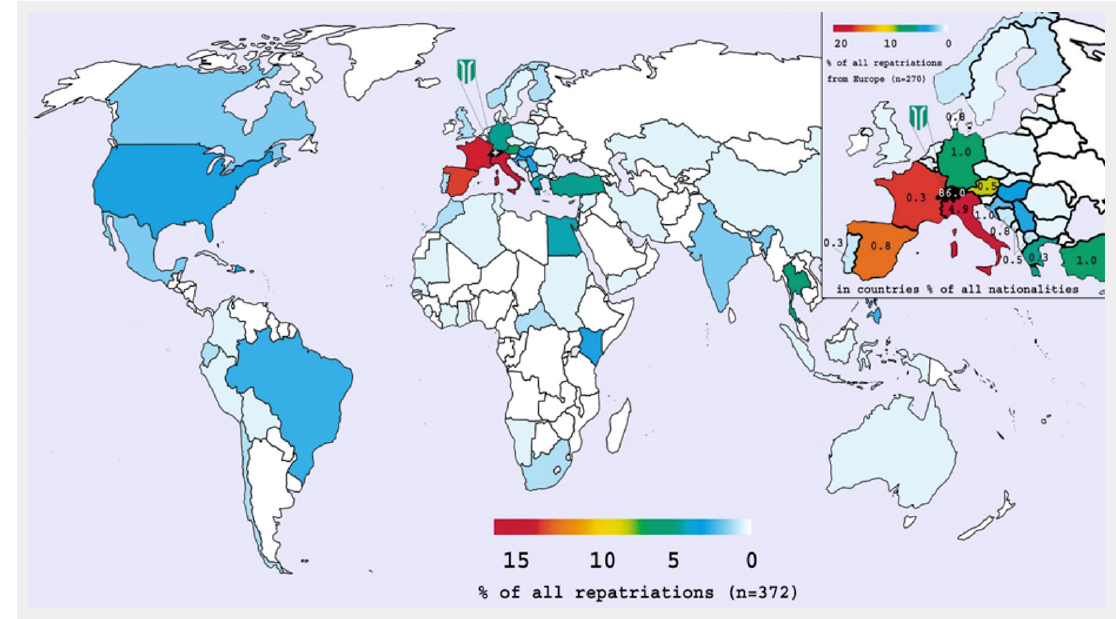
Figure 3 The percentages per country indicate the proportion of repatriated patients to the Inselspital Bern, who were nationals of this country (e.g. 4.9% of repatriated patients were Italians). The colour of the countries indicates the percentage of all repatriations from that country to Inselspital